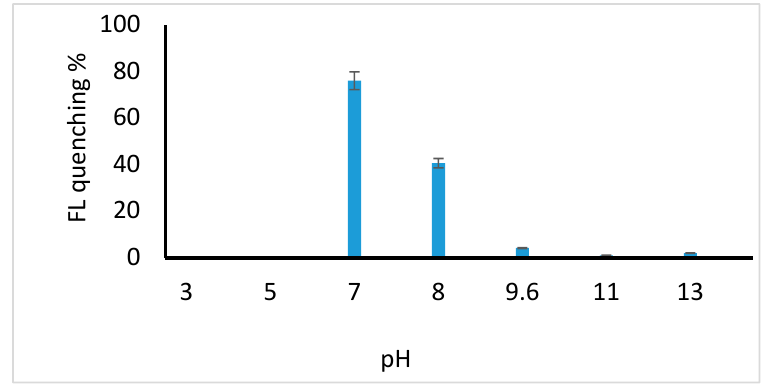
Figure 2. Effect of pH on QDs fluorescence quenching by verapamil HCl.